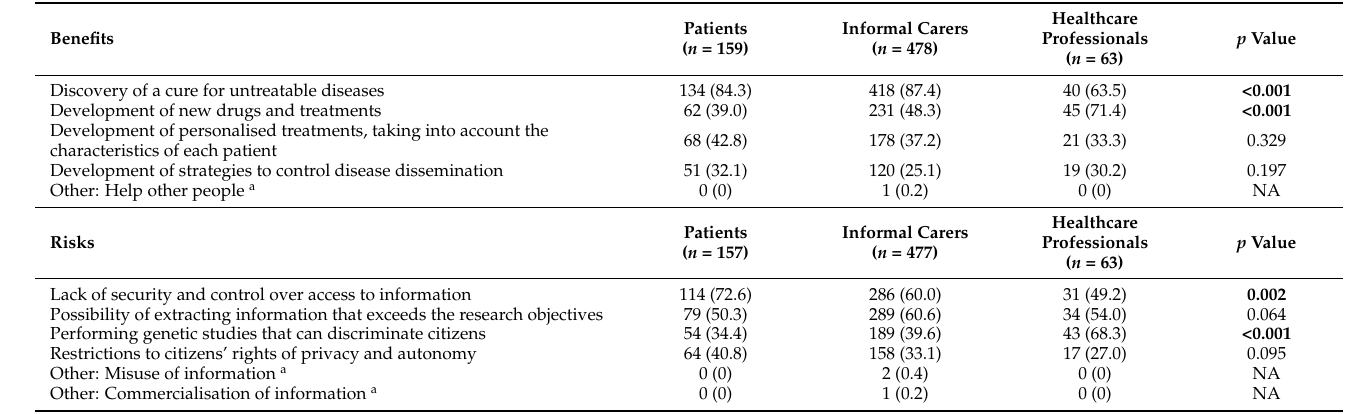
Table 2. Participants’ views about the two most important benefits and risks of sharing genetic information for